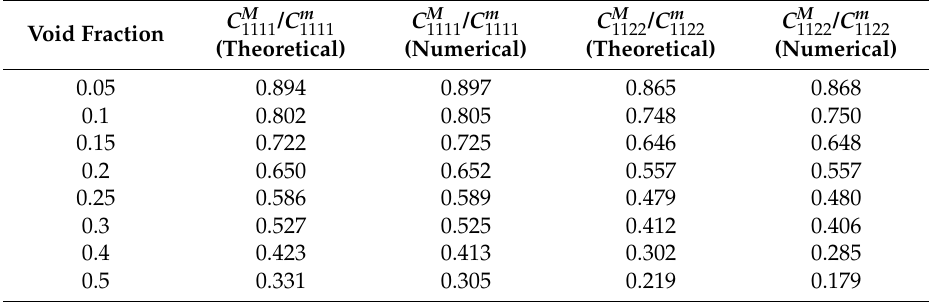
Figure 8. Theoretical estimates [47] versus numerical values of effective elastic moduli of a body with spherical voids (void fraction φ ). ( a ) 𝐶 (cid:2869)(cid:2869)(cid:2869)(cid:2869)(cid:3014) /𝐶 (cid:2869)(cid:2869)(cid:2869)(cid:2869)(cid:3040) ; ( b ) 𝐶 (cid:2869)(cid:2869)(cid:2870)(cid:2870)(cid:3014) /𝐶 (cid:2869)(cid:2869)(cid:2870)(cid:2870)(cid:3040) . Table 1. Theoretical estimates versus numerical values of effective elastic moduli of a body with spherical